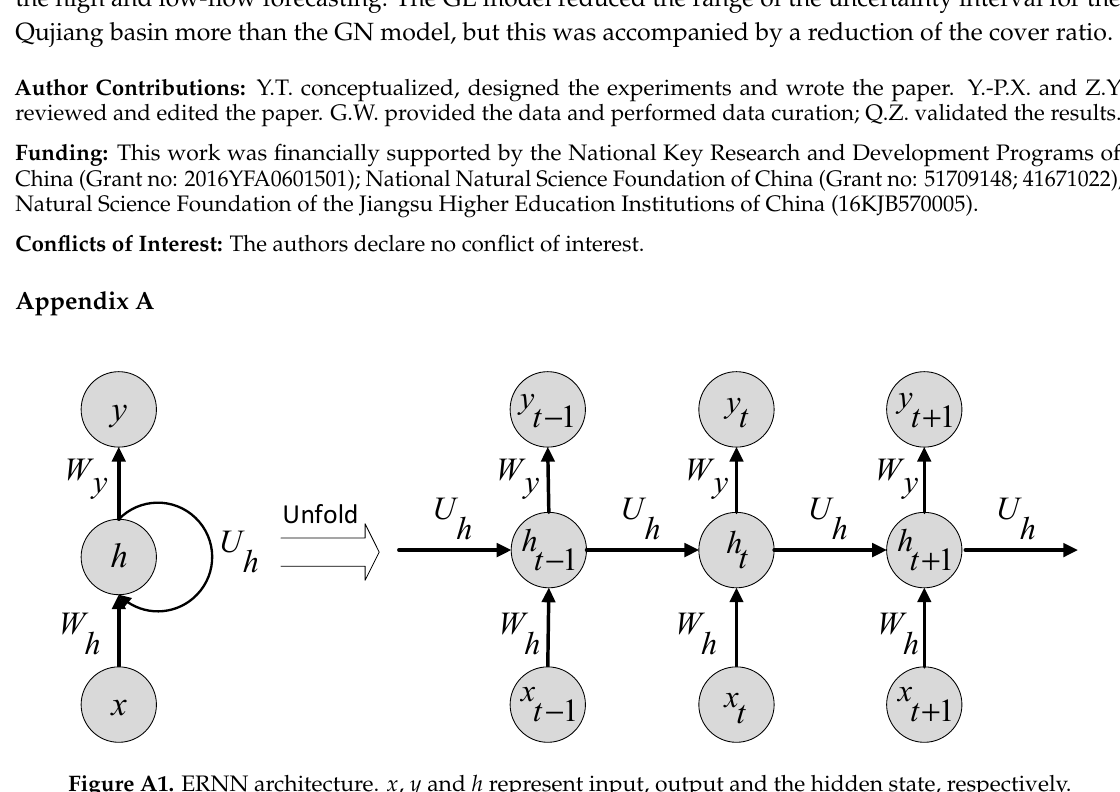
Figure A1. ERNN architecture. x , y and h represent input, output and the hidden state, respectively. W h , U h and W y represent weighted matrices between the input and the hidden layers, the context units and the hidden layers, and the hidden layers and the output, respectively.